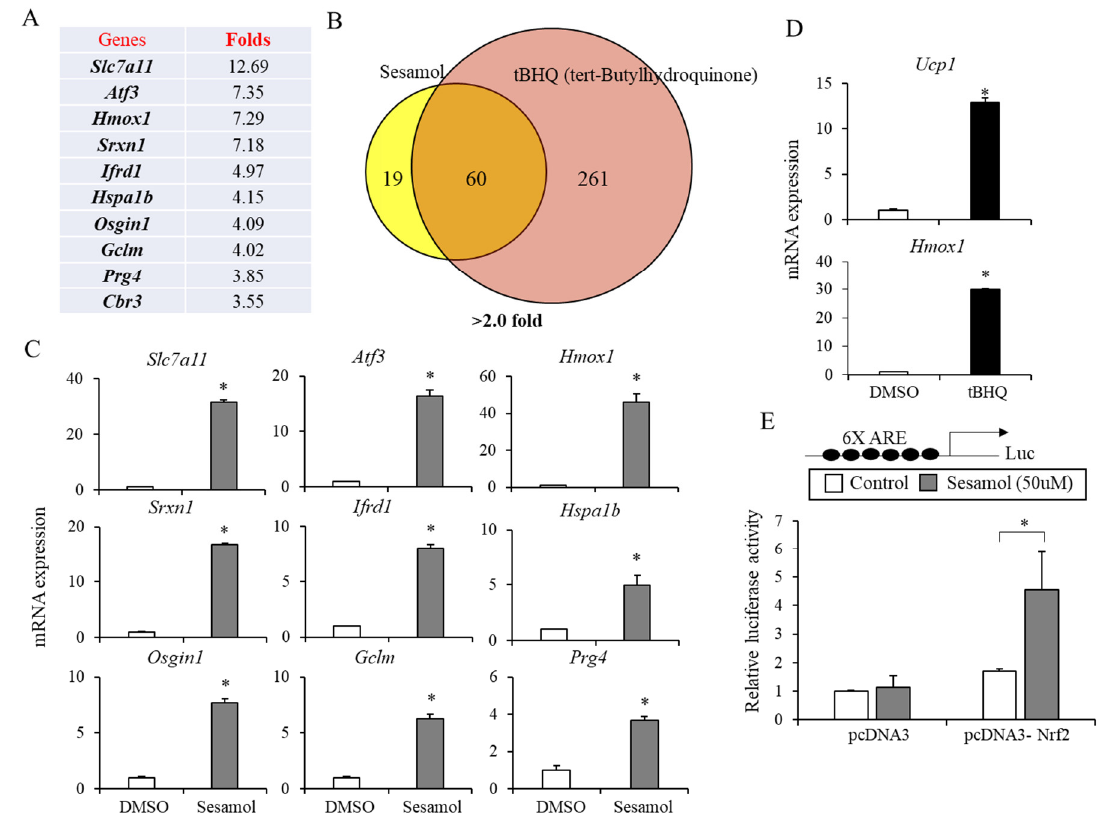
Figure 6. Sesamol stimulates the Nrf2 activation in adipocytes. ( A ) C3H10T1 / 2 adipocytes were treated with sesamol (50 µ M) for 12 h and the gene expression profiles were analyzed by a microarray analysis. Lists of 10 most highly induced genes (solute carrier family 7 member 11 (Slc7a11), activating transcription factor 3 ( Atf3 ), Hmox1 , Srxn1 , interferon-related developmental regulator 1 ( Ifrd1 ), heat shock protein family a member 1b ( Hspa1b ), oxidative stress induced growth inhibitor 1 ( Osgin1 ), Gclm , proteoglycan 4 ( Prg4 ), and carbonyl reductase 3 ( Cbr3 ))by sesamol were shown. ( B ) Expression profiles of C3H10T1 / 2 adipocytes treated with either sesamol (50 µ M) or tert-butylhydroquinone (tBHQ, 50 µ M) were compared. Diagram showing the number of genes ( > 2.0 fold) regulated by sesamol or tBHQ. ( C ) Expression of sesamol (50 µ M)-induced genes in C3H10T1 / 2 adipocytes were confirmed by real-time PCR. ( D ) Induction of the Ucp1 and Hmox1 mRNA expressions by tBHQ in C3H10T1 / 2 adipocytes. ( E ) HEK293T cells were transfected with the Nrf2-dependent antioxidant response element (ARE) luciferase reporter construct (6XARE) and an expression vector coding for Nrf2 (pcDNA3-Nrf2). After 36 h, cells were treated with DMSO (control) or sesamol for an additional 12 h and the firefly luciferase activity was measured. The firefly luciferase enzyme activity was normalized to the Renilla luciferase enzyme activity. Data are means ± standard deviations ( n = 3). Statistical significance was determined by comparison with the control using Student’s t -test (* p < 0.05).